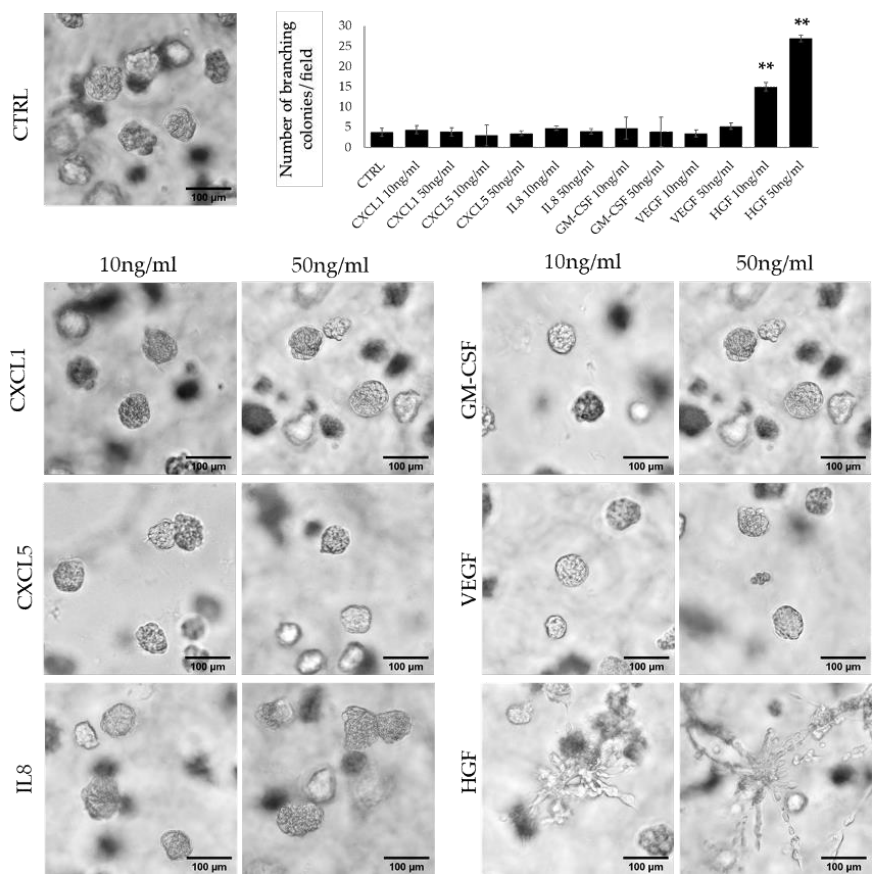
Figure 2. 3D matrigel cultures of MBA-MB-231 cells treated with selected cytokines in two concen- trations (10 ng/mL and 50 ng/mL), only HGF induced colony branching. ** p < 0.001 calculated vs control; culture photographs were taken using 10× objective. The graph represents the number of branching colonies per visible field.